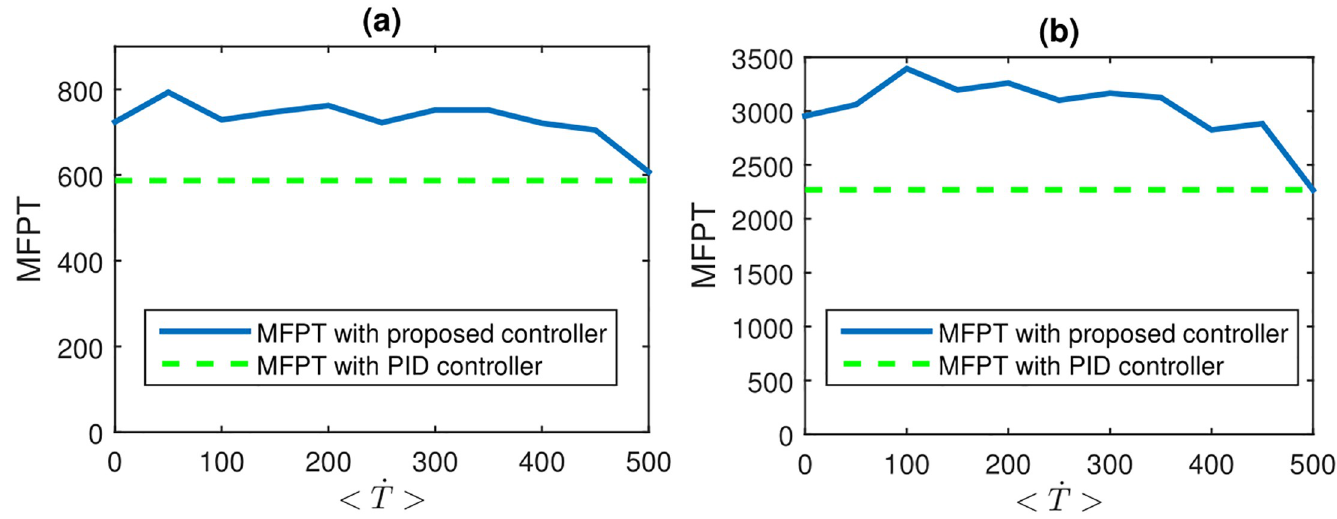
Fig 11. MFPT profile with respect to < _ T > compared to MFPT with the use of PID controller, both with ω ctrl = 5 σ for (a) scenario I ( μ ¼ N ð 0 : 45 ; 0 : 08 2 Þ and η ¼ N ð 0 : 6 ; 0 : 1 2 Þ ) and (b) scenario II ( μ ¼ N ð 0 : 45 ; 0 : 07 2 Þ and η ¼ N ð 0 : 6 ; 0 : 1 2 Þ ).